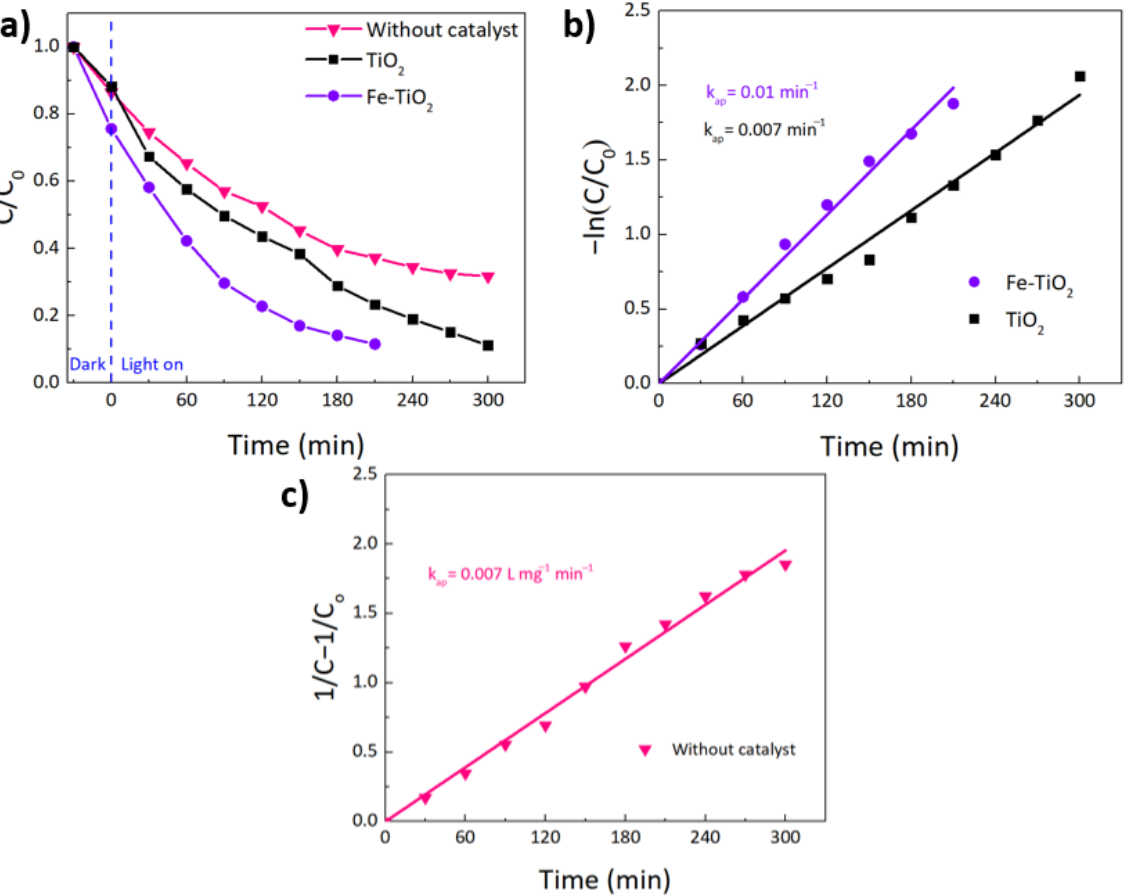
Figure 11. ( a ) RhB degradation ratio (C/C 0 ) vs. exposure time for the impregnated substrates (with pure TiO 2 and 5 mol% of Fe ‐ TiO 2 photocatalysts) and the pristine substrate (without catalyst), under a sunlight simulator. ( b ) Pseudo ‐ first order kinetics for RhB photocatalytic degradation of the inves ‐ tigated impregnated substrates. ( c ) Pseudo ‐ second order kinetics for RhB photocatalytic degrada ‐ tion of the pristine substrate (without catalyst).